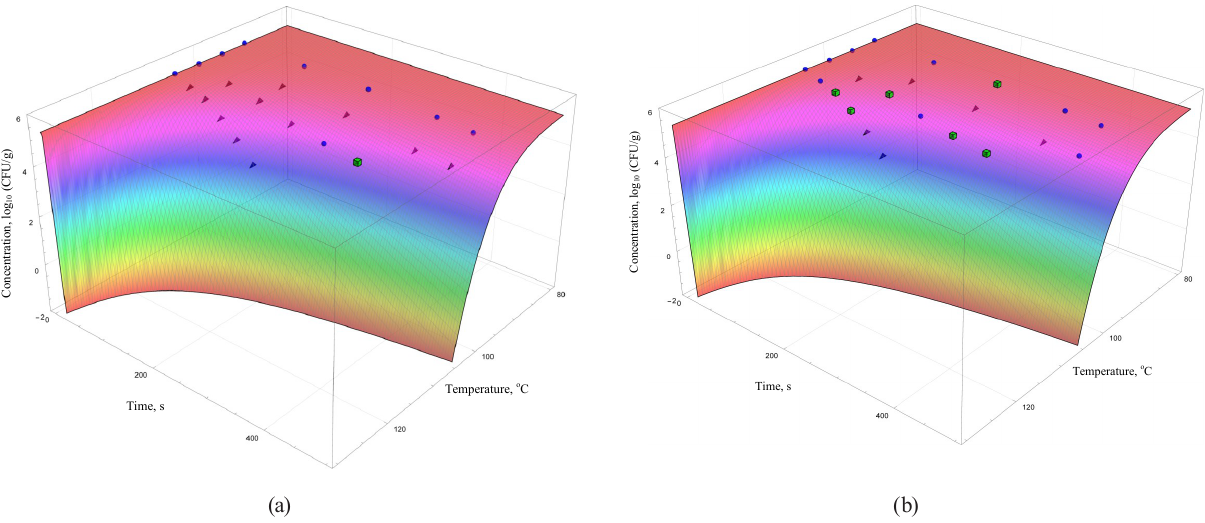
(a) the Fermi model, (b) Kamau model.